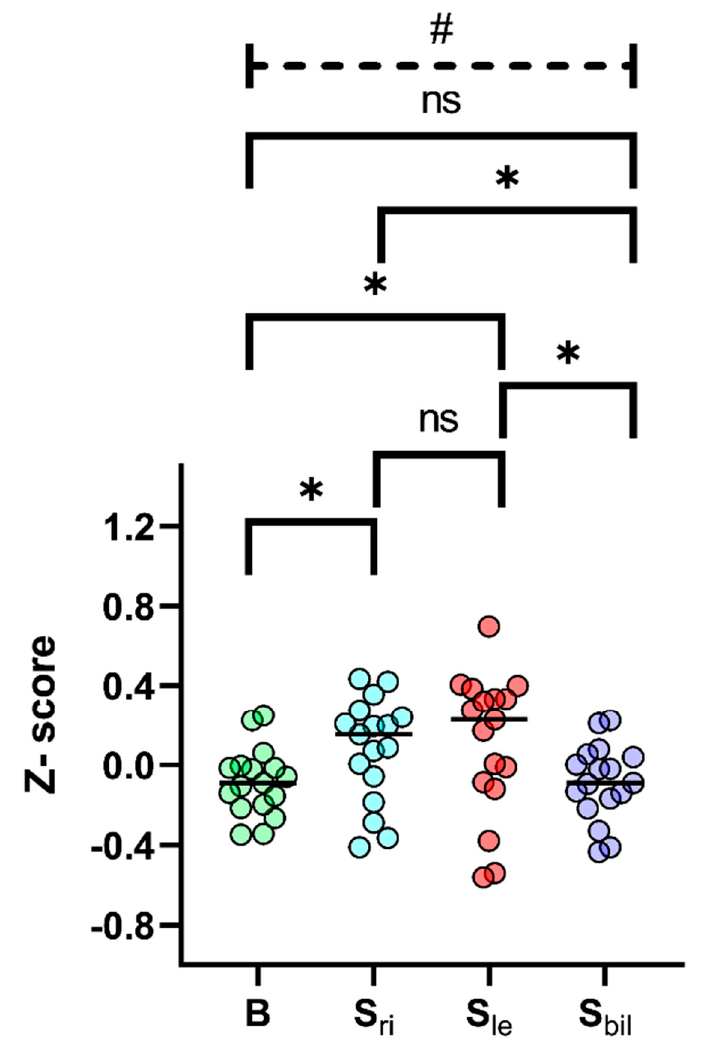
Figure 1. Median z -scores for all neuropsychological tests subdivided by site of onset (bulbar vs. spinal onset) and side of onset for spinal onset patients (right-side vs. left-side vs. bilateral onset). # Kruskal–Wallis test p < 0.05; * Mann–Whitney U test (with Bonferroni’s correction) p < 0.05. The black horizontal lines identified the median z -score for all tests. B, bulbar onset patients; S ri , right-side spinal onset; S le , left-side spinal onset; S bil , bilateral spinal onset.